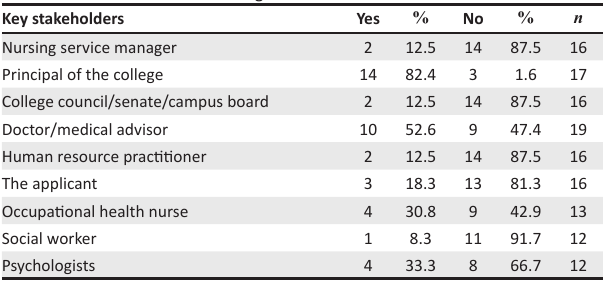
TABLE 1: Key stakeholders involved in decision-making regarding the students’ fitness to undertake nurse